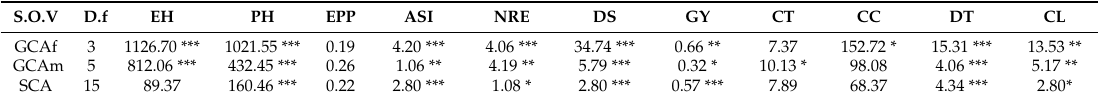
Table 4. Mean sum of square e ff ects of GCAm, GCAf and SCA for yield, yield components and other morpho-agronomic traits under optimum